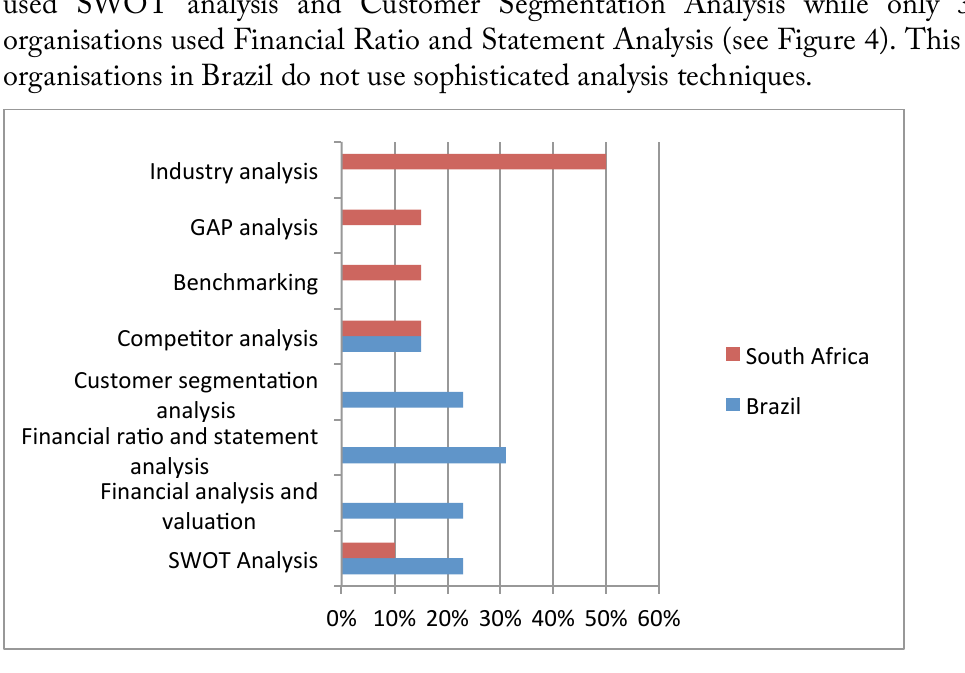
Figure 4: Analysis methods or models